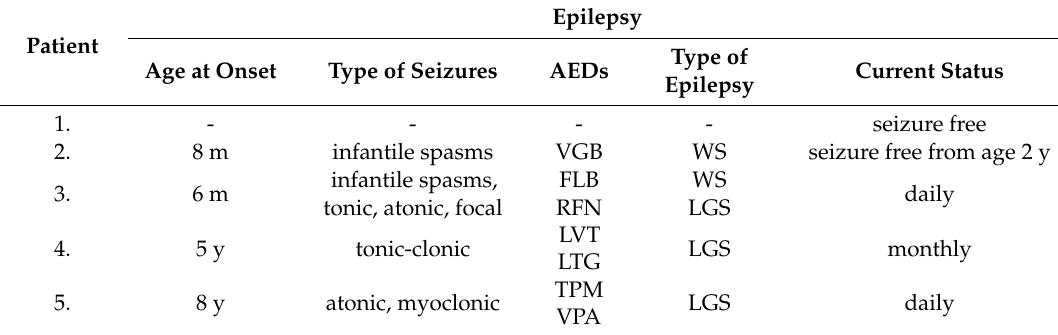
Table 2. Summary of epilepsy related